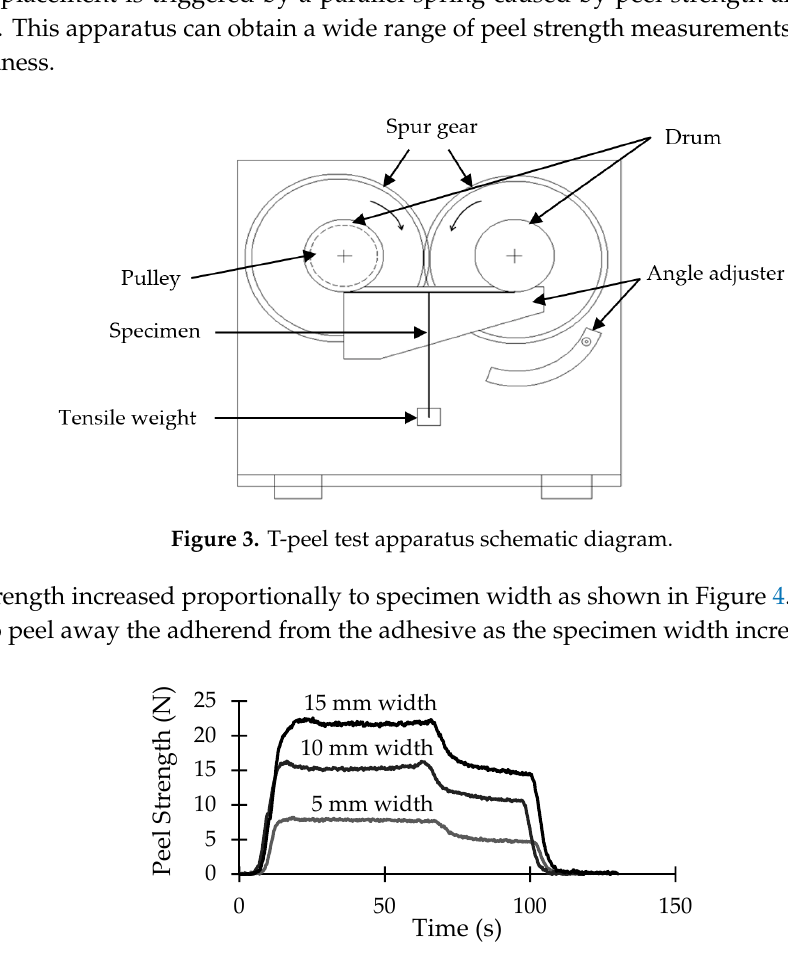
Figure 4. Peel strength increased proportionally to specimen width.